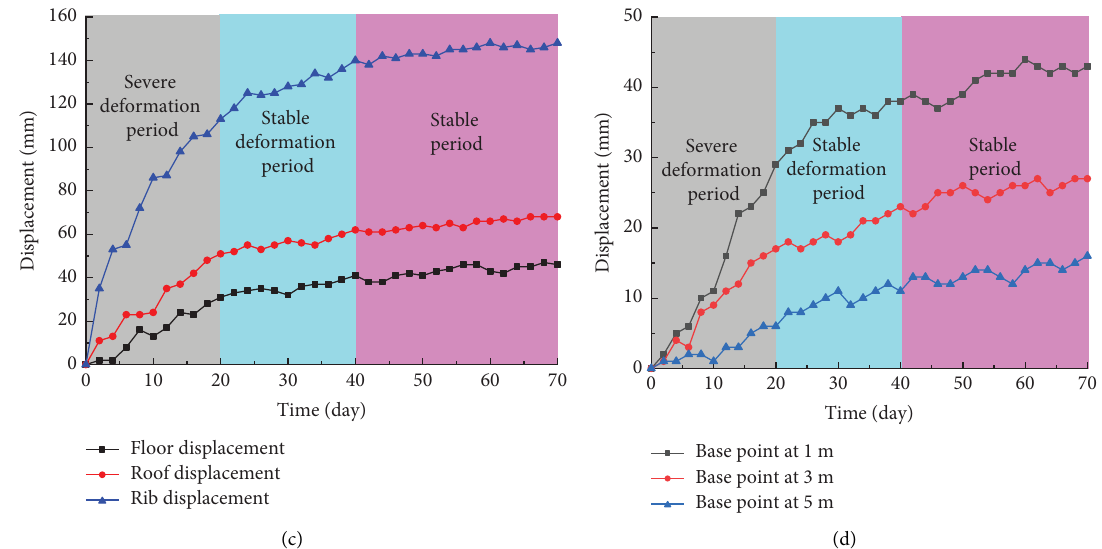
Figure 15: Monitoring results: (a) layout of monitoring station; (b) stress curve of bolts and cables; (c) roadway surface deformation; (d) internal deformation of surrounding rock.